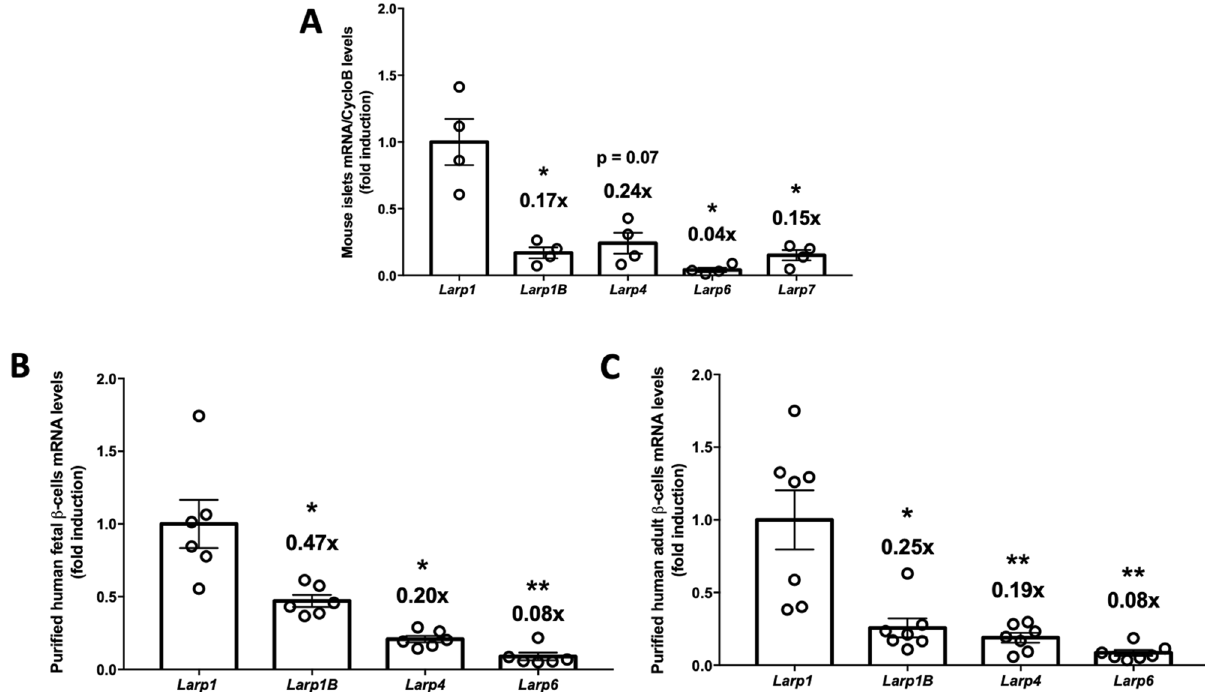
Figure 1. LARP1 is the most expressed LARP in mouse islets and human β-cells. ( A ) LARP family mRNA levels in isolated mouse islets, ( B ) LARP family gene expression in human fetal β-cells and ( C ) Same as in B except that adult human β-cells were used *p < 0.05, **p < 0.01 and ***p < 0.001 compared to LARP1 mRNA levels assessed by one-way analysis of variance ( ANOVA ) followed by Dunnet’s posthoc test. Numbers on top of the bars denote fold reduction. Figures B and C are analysis of RNA sequencing publicly available database by Blodgett et al. 29